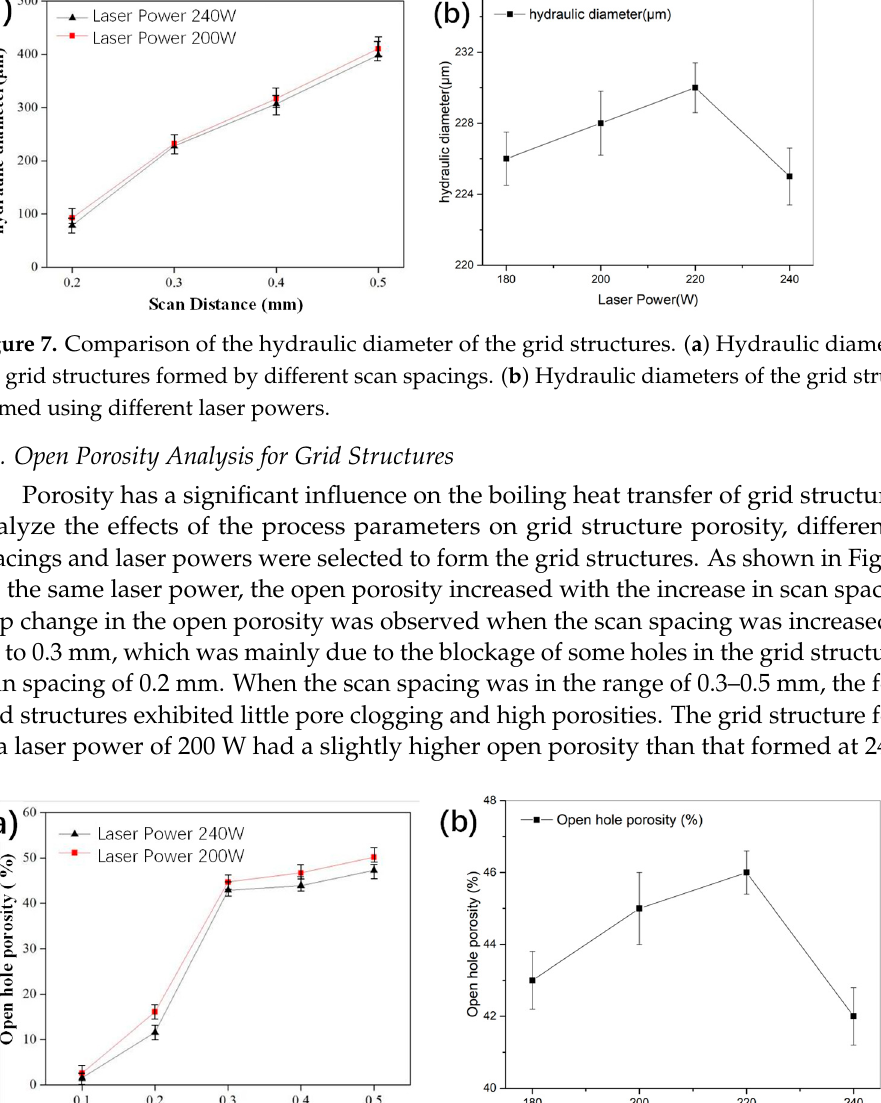
Figure 7. Comparison of the hydraulic diameter of the grid structures. ( a ) Hydraulic diameters of the grid structures formed by different scan spacings. ( b ) Hydraulic diameters of the grid structures formed using different laser powers.